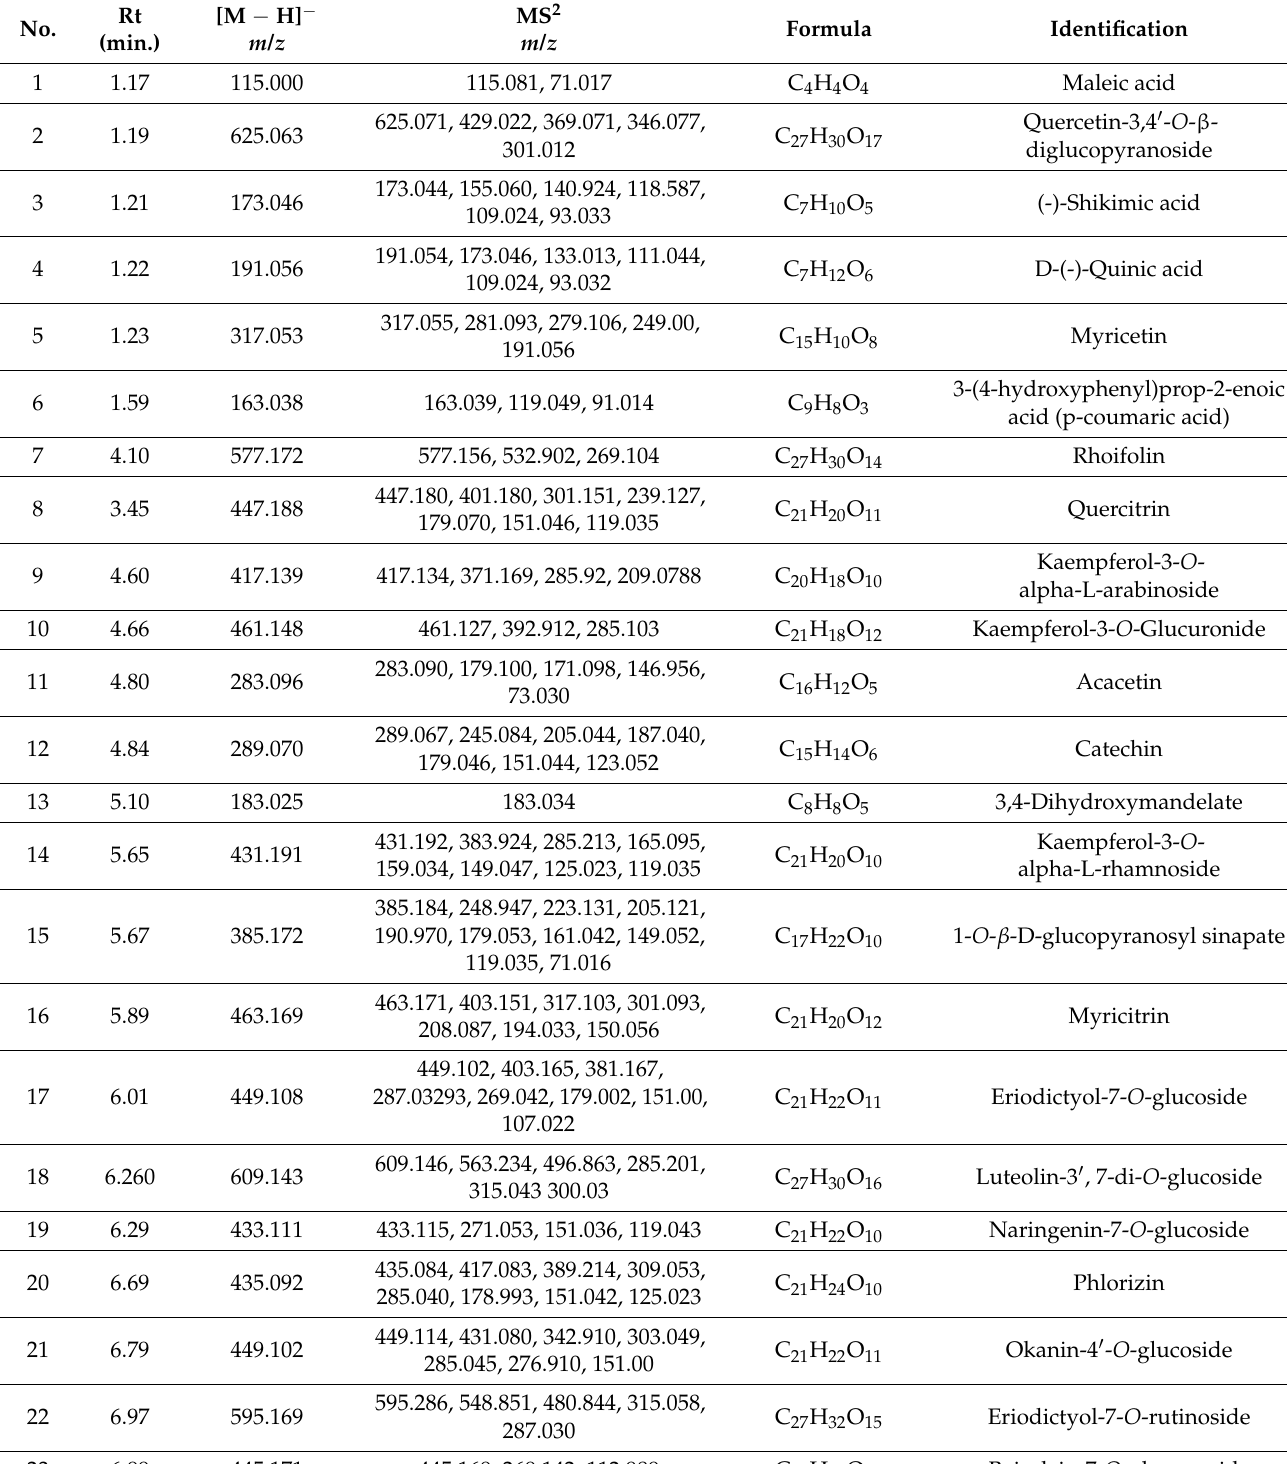
tified. Results are listed in Table 1. The total ion chromatogram (TIC) of methanol extract of C. macrocarpa leaves (negative mode) is presented in Supplementary Materials Figure S1. Whereas, the structures of different compounds are demonstrated in Supplementary Mate- rials Figures S2 and S3. Table 1. Phytochemical profiling of C. macrocarpa leaves extract by LC-ESI-MS/MS in negative mode.